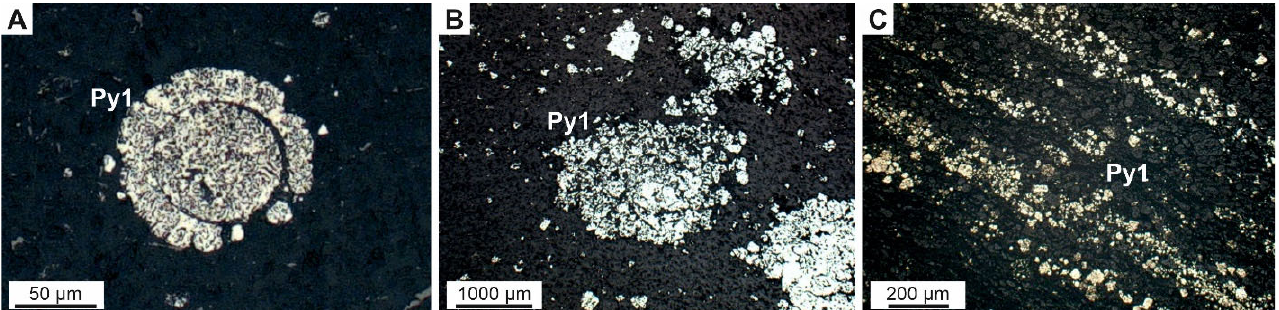
Figure 8. Microtexture of diagenetic Py1 (reflected light) OGDs, central YKMB: ( A ) framboids and zonal structure; ( B ) nodular aggregate pyrite and marcasite as anhedral-to-colloform grains; ( C ) layered arrangement of Py1 crystals in siltstone.